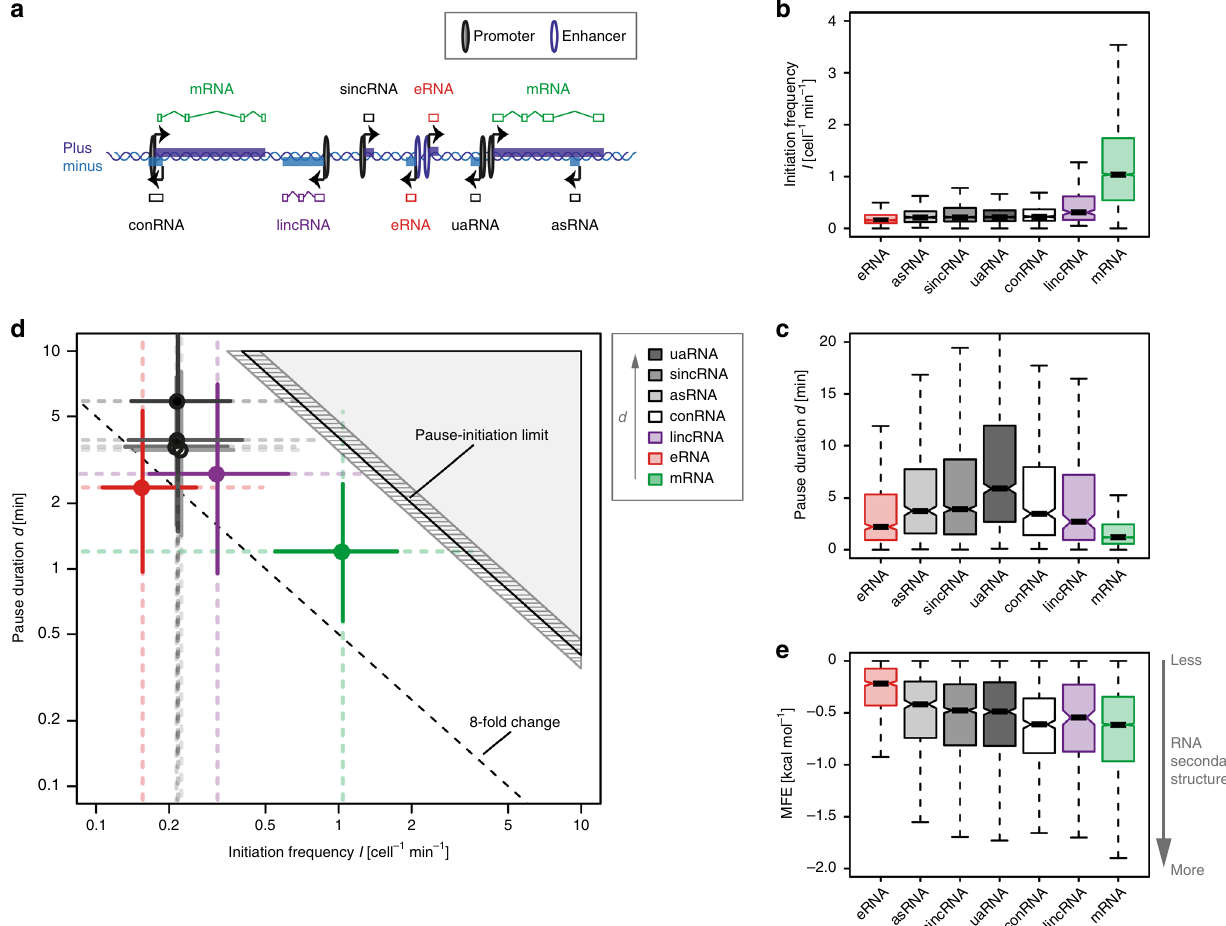
Fig. 2 Transcription kinetics of different gene classes in steady state. a Schematic representation of seven major transcript classes annotated in this study: 604 eRNAs (in light red), 471 asRNAs, 1314 sincRNAs, 965 uaRNAs, 445 conRNAs (in different shades of gray), 209 lincRNAs (in purple), and 6355 mRNAs (in green), depicted on plus (dark blue) or minus (light blue) strand ( “ Methods ” ). b Boxplots of productive initiation frequency I [cell − 1 min − 1 ] for transcript classes de fi ned in a . Black bars represent medians, boxes span from upper to lower quartiles, and whiskers represent 1.5 times the interquartile range. c Boxplots of pause duration d [min]. d Plot shows the median productive initiation frequency I [cell − 1 min − 1 ] depicted against the median pause duration d [min] for all transcript classes (circles) in log scale. The two solid perpendicular lines de fi ne the interquartile range, and the dotted whiskers represent 1.5 times the interquartile range of the respective estimates for the entire transcript class. The gray shaded area depicts impossible combinations of I and d 27,28 . Striped area shows con fi dence intervals of the pause-initiation limit. The dotted line de fi nes an eightfold possible fold change until a gene would be restricted by the pause-initiation limit. e Boxplots of minimum free energy MFE [kcal mol − 1 ]. MFE was calculated in a window of [ − 15, − 65] bp upstream of the pause site to predict RNA secondary structure 79 for each transcript in a transcript